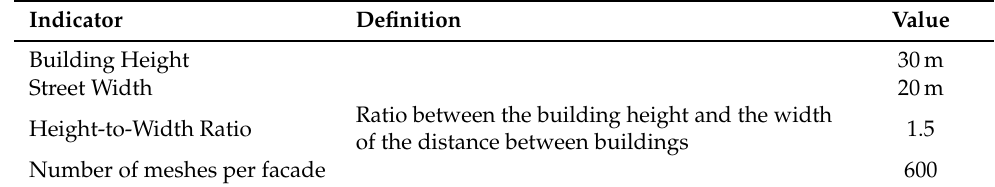
Figure 7. Sketch of the homogeneous neighborhood. Table 3. Urban morphology indicators specific to the homogeneous district.